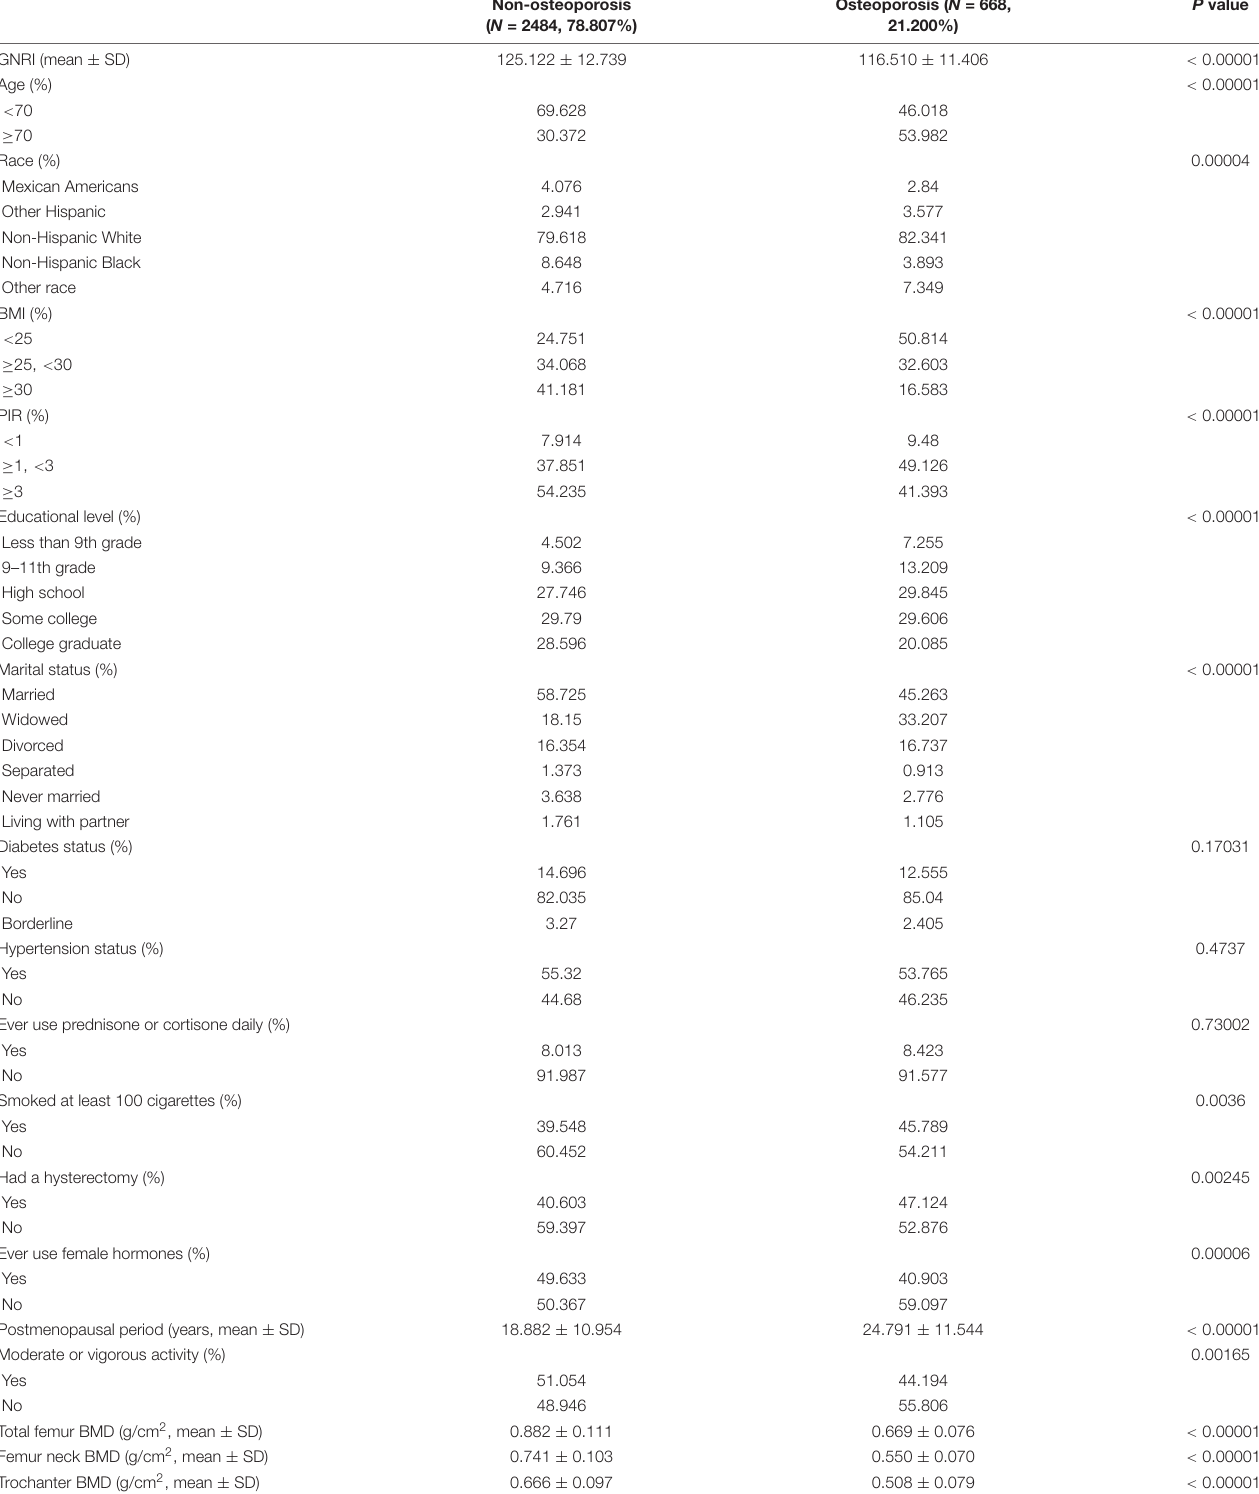
TABLE 1 | Weighted characteristics of the study